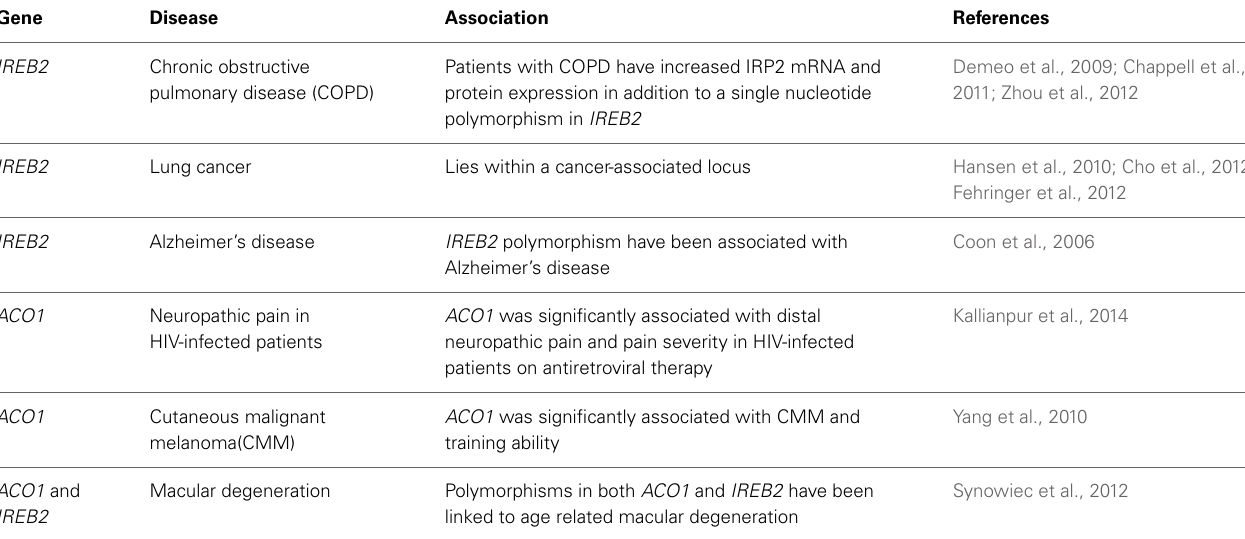
Table 2 | Genome-wide association studies (GWAS) with the IRPI and IRP2 genes, ACO1 and IREB2 , respectively.